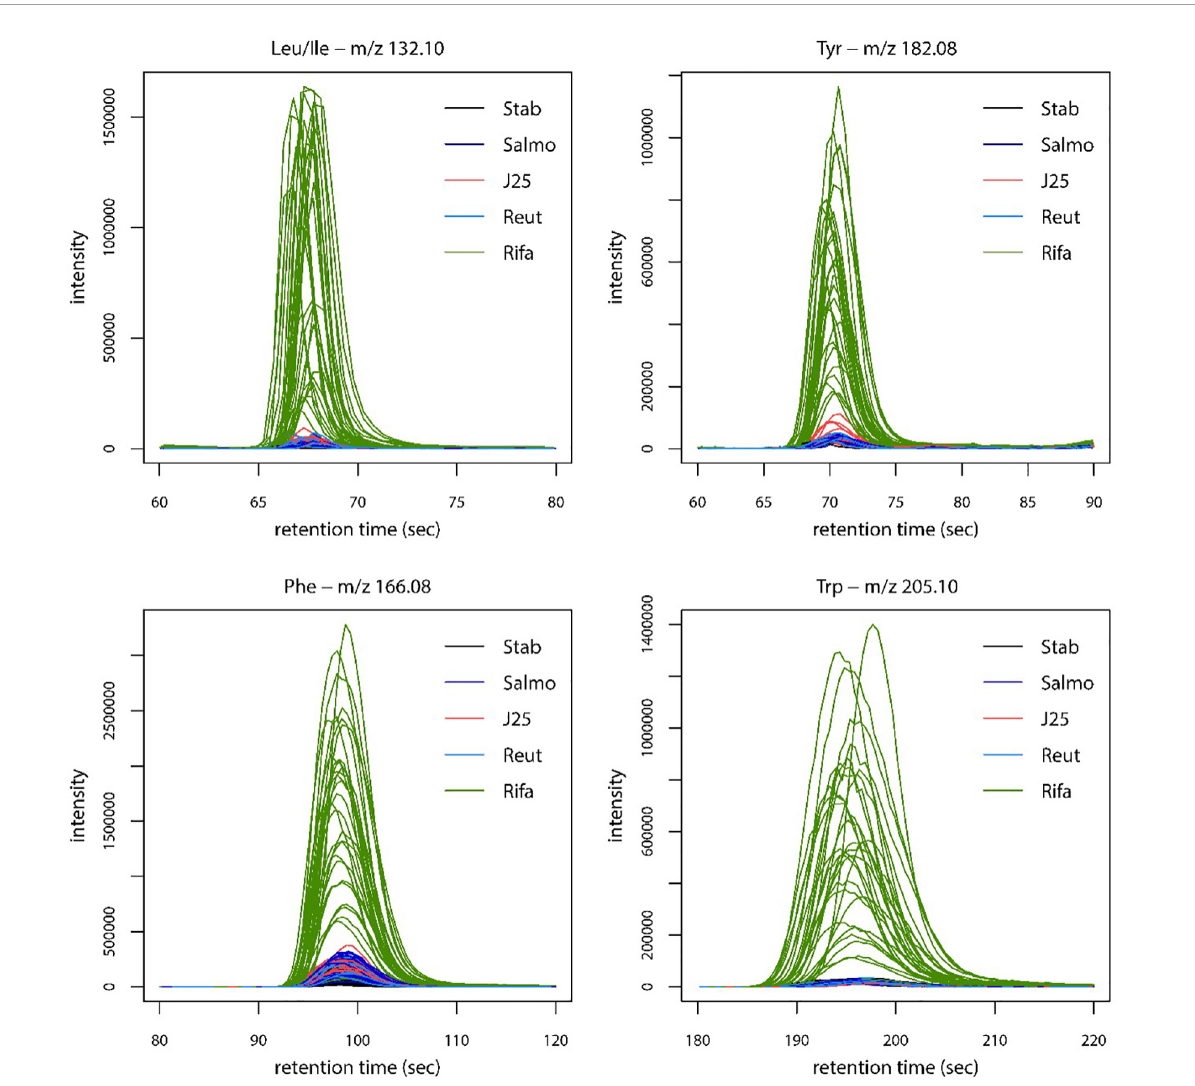
FIGURE7 Extracted ion chromatograms representing the relative intensity of Leu/Ile, Tyr, Phe and Trp amino acids in swine microbiota metabolome extracts, for each treatment. Stab: stabilization, Salmo: Salmonella Newport treatment, J25: Salmonella Newport + 0.4 mM MccJ25 treatment, Reut: Salmonella Newport + 4 mM reuterin treatment, Rifa: Salmonella Newport + 0.6 mM rifampicin